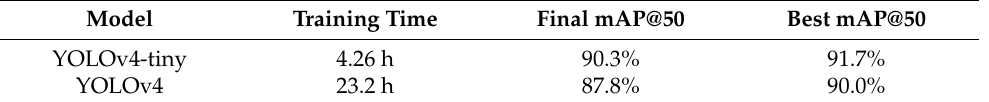
grade of overlapping bounding boxes of 50%) of the two trained models obtained on the test dataset.